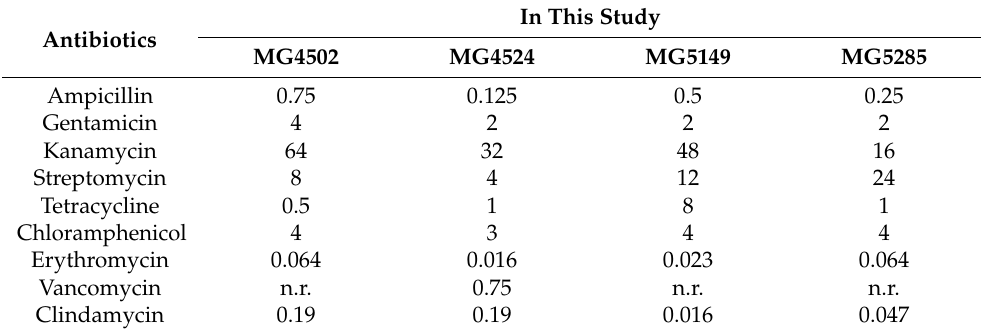
Table 3. Minimum inhibitory concentrations (MICs) of various antibiotics for the selected